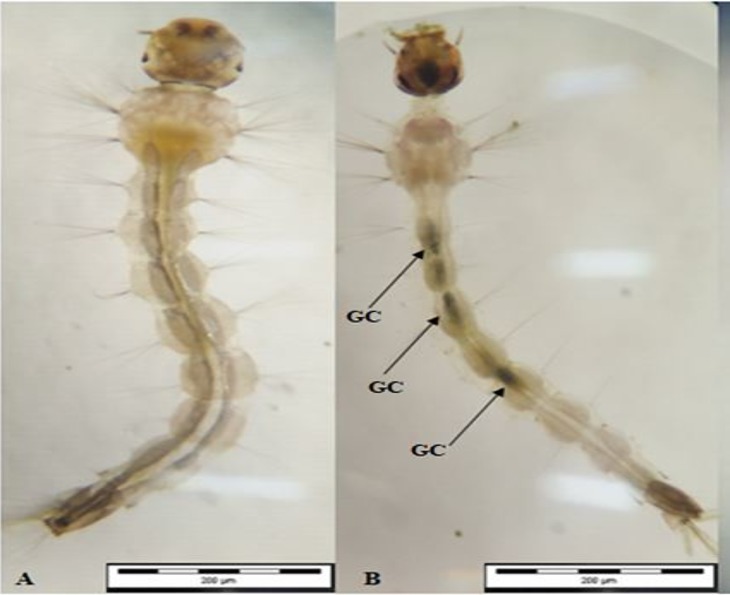
Morphological midgut content induced by Azolla pinnata plant extract from maceration extraction method in larvae of Ae. Aegypti.(A) Control test for midgut content view in early 4th instar larvae of Ae. Aegypti (B) A. pinnata crude extract for midgut content view in larvae of Ae. Aegypti Note: Arrows indicating the plant extracts (greenish color), GC: gut content (after 24hours).